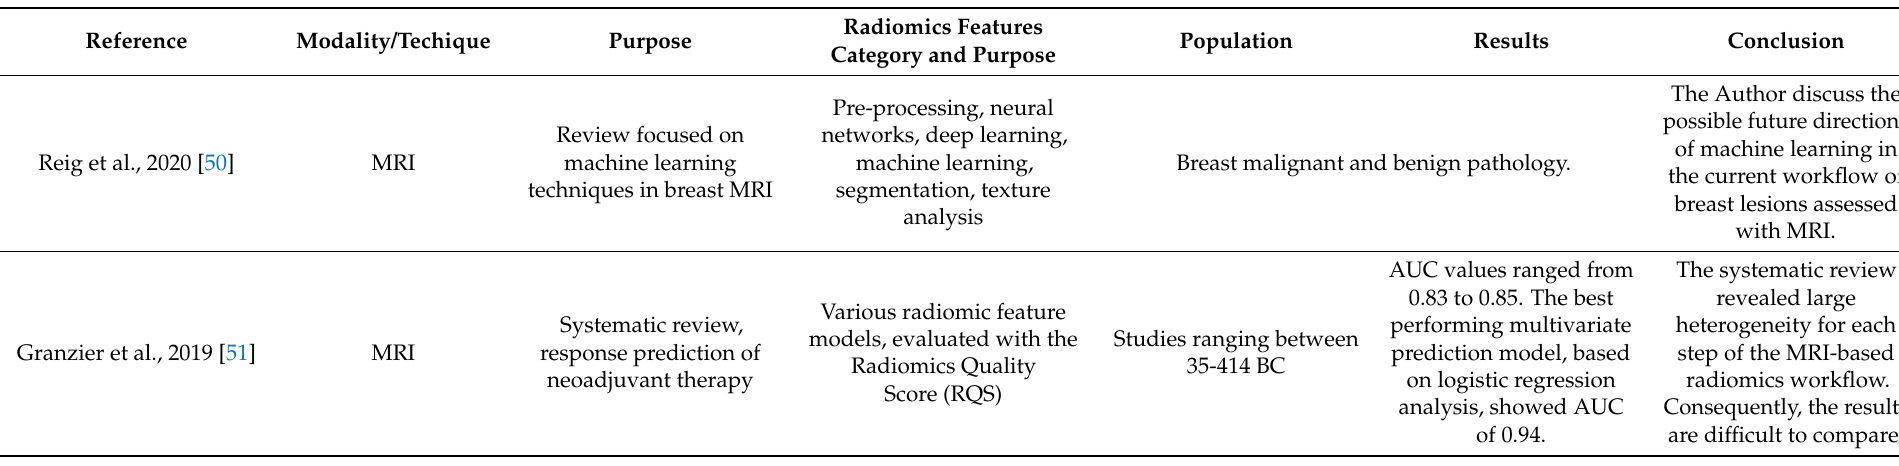
Table 2. Review studies on radiomics in breast imaging published in peer reviewed journals from 01/2018 to 01/2021, ordered by newest